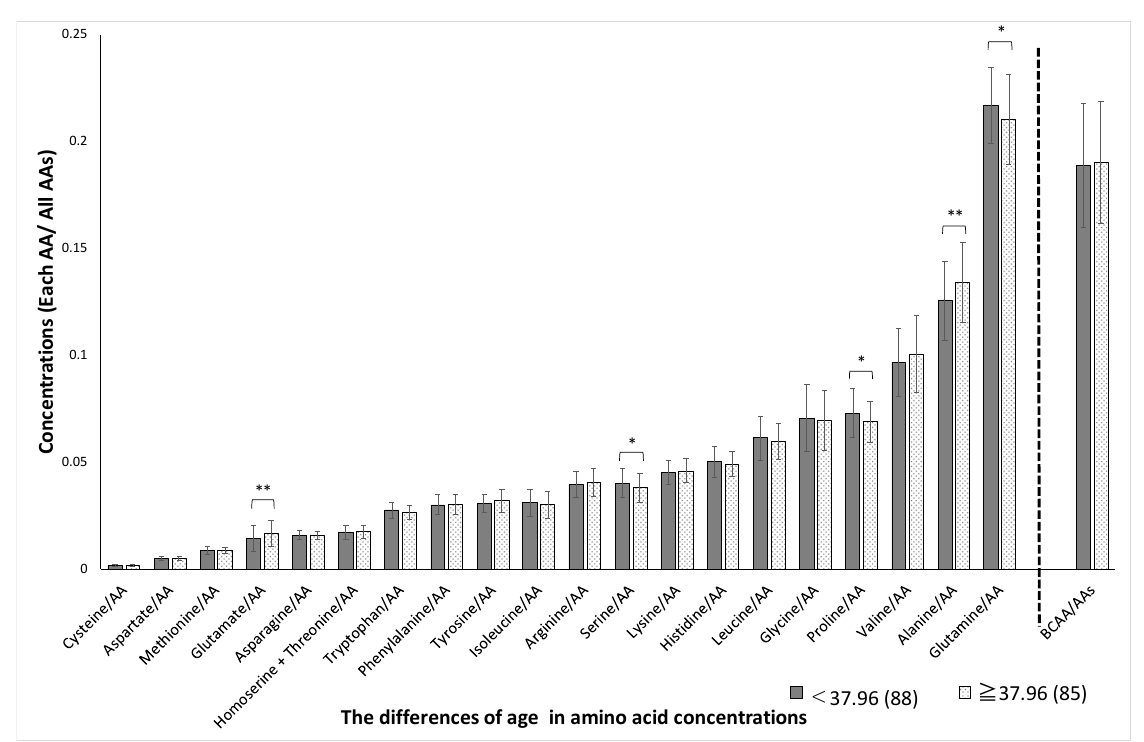
Figure 2. Age-related differences in amino acid concentrations. The absolute concentration was divided by the total AA concentration, yielding the relative concentration. Participants were divided into two groups based on age, with a median of 37.96 years. AAs, amino acids; BCAAs, branched-chain amino acids. * p < 0.05, ** p < 0.01 in age < 37.96 versus age ≥ 37.96.